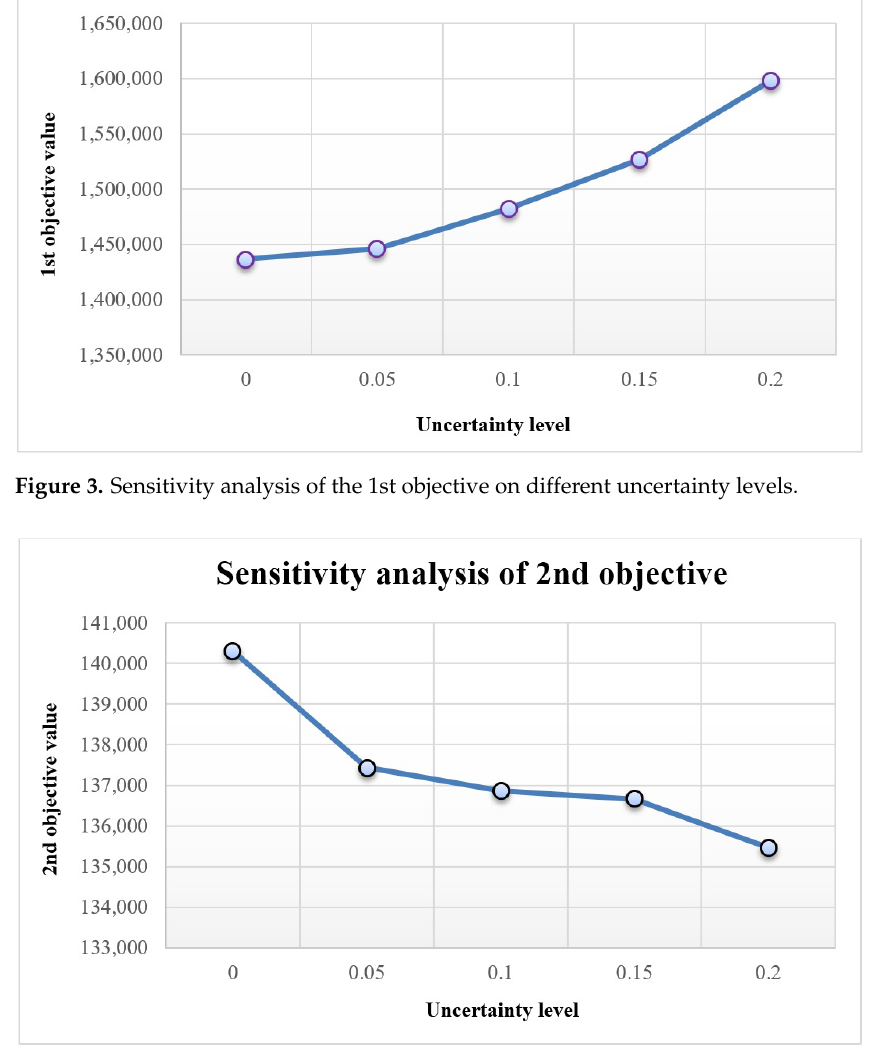
Figure 4. Sensitivity analysis of the 2nd objective on different uncertainty